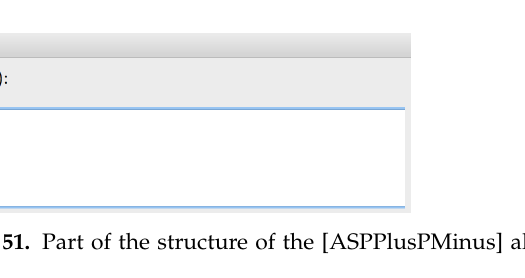
Figure 50. Output given by the [ASPPlusPMinus] algorithm.